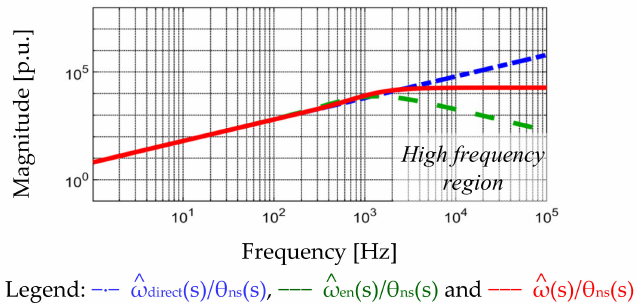
Figure 10. Frequency response of estimation noise attenuation among different speed estimations (ideal parameter estimation, ˆK t = K t and ˆJ ALL = J ALL